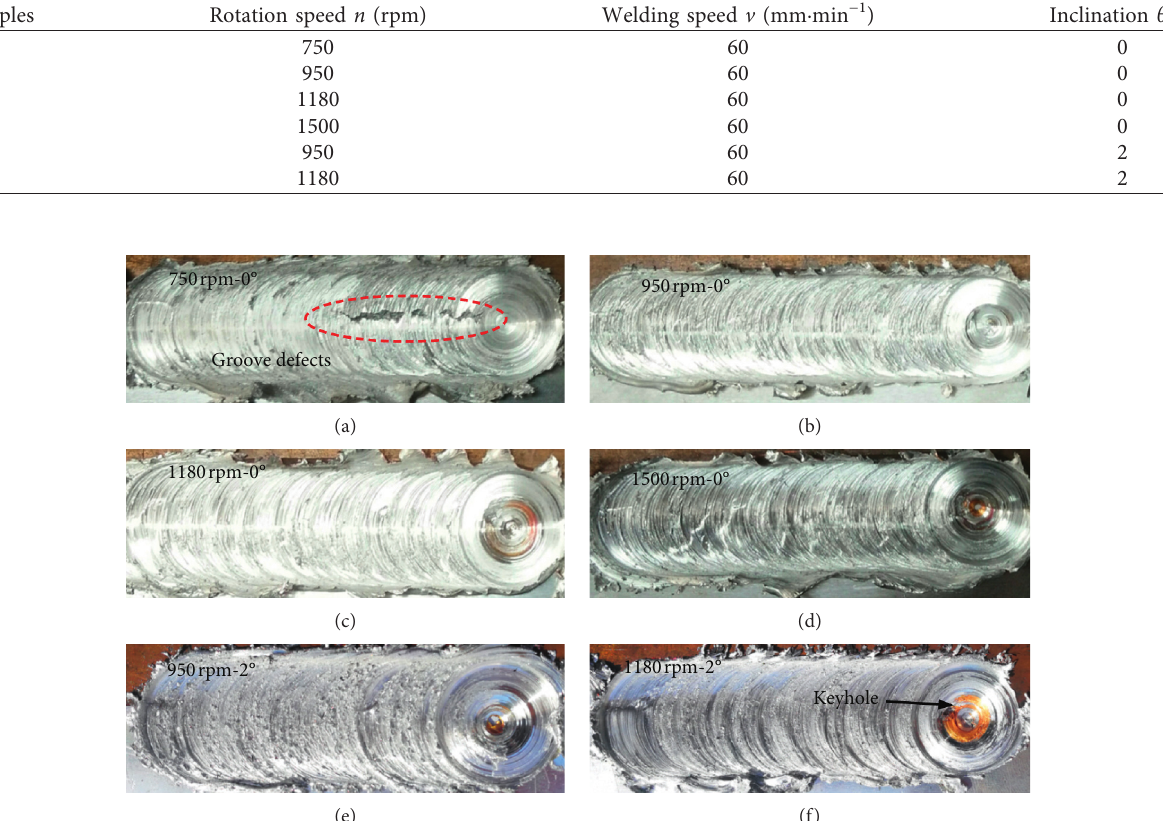
Figure 2: The weld surface morphology of Al-Cu FSW joint produced by (a) 750rpm-0 ° , (b) 950rpm-0 ° , (c) 1180rpm-0 ° , (d) 1500rpm-0 ° , (e) 950rpm-2 ° , and (f) 1180rpm-2 °